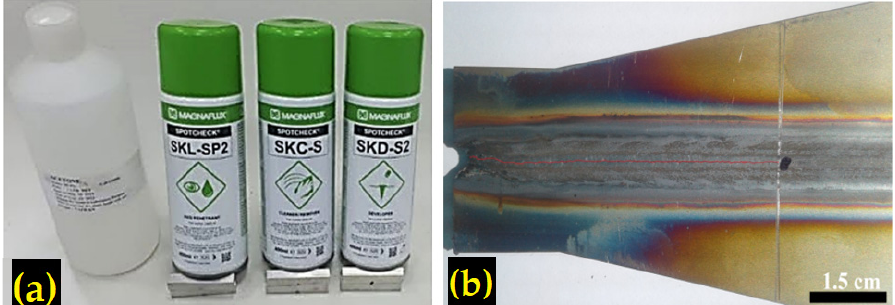
Table 3. Welding parameters.